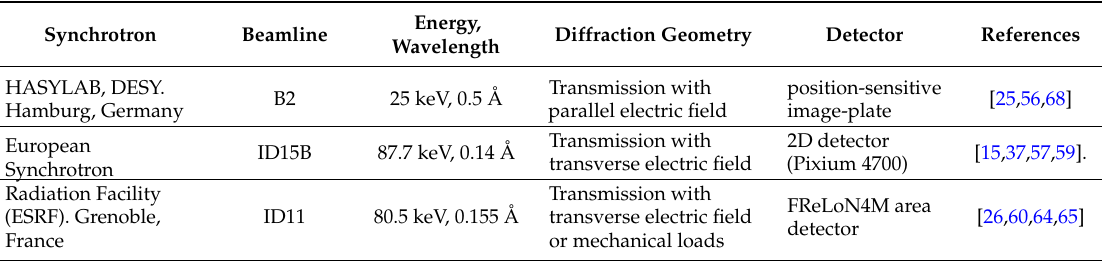
Table 2. Some synchrotrons active in research on ferroelectricity.